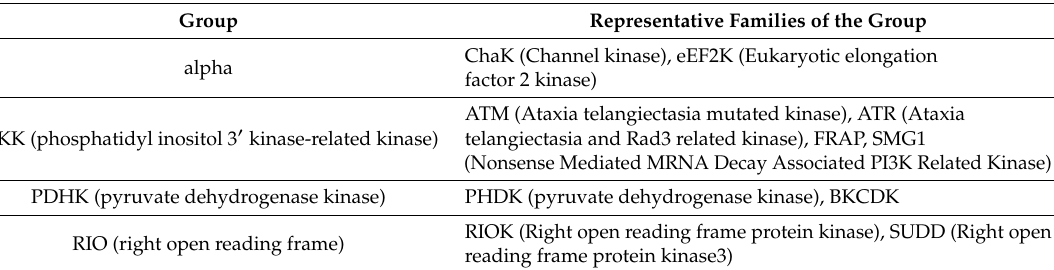
Table 2. Classification of atypical protein kinases